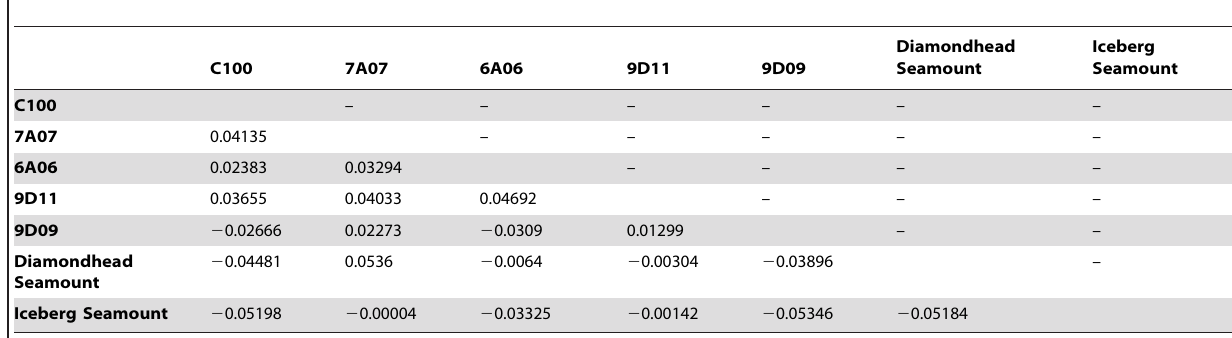
Table 5. Pairwise Fst values between populations of the squat lobster, Munida gracilis , using a fragment of the COI gene.